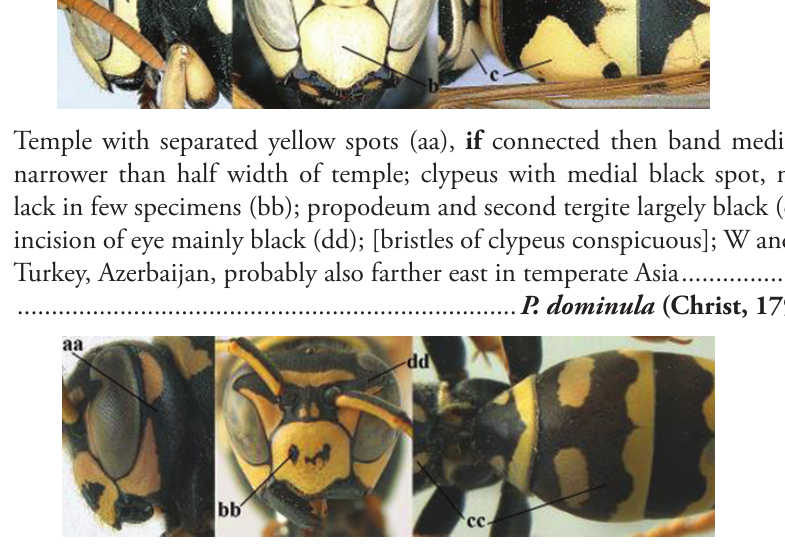
15 Posterolateral yellow bands of pronotum usually not connected to anterior transverse band (a); anterior transverse yellow band of pronotum medio-lat- erally as wide as dorso-laterally or wider (b); mesoscutum with paired yellow spots (c); [clypeus with transverse black band; hypopygium all black, with apical yellow or reddish spot or entirely reddish; distinction from P. nimpha in SW Asia is not always possible, because P. nimpha is highly variable in this region; usually sculpture of ventral part of mesopleuron finer in P. associus than in P. nimpha ]; southern Europe, western Asia .... P. associus Kohl, 1898